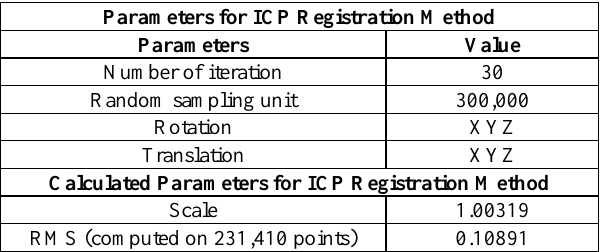
Table 5. Summary of the parameters involve in ICP registration method